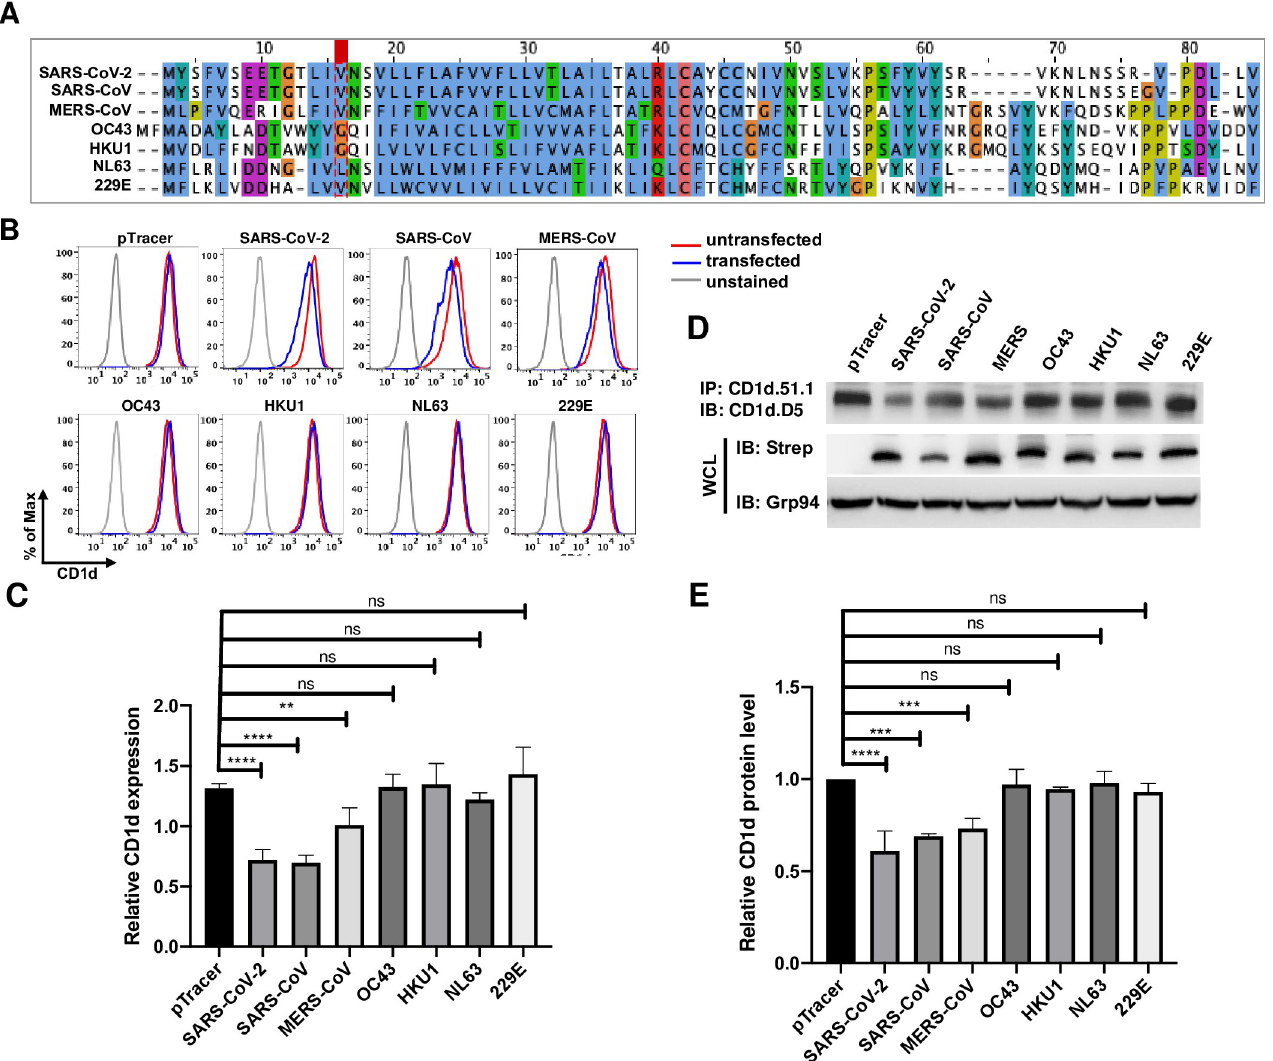
Fig 7. Only E proteins from highly pathogenic coronaviruses, but not common cold viruses downregulate CD1d expression. (A). Amino acid sequence alignment of E proteins from seven human coronaviruses. (B, C). 293T.CD1d cells were transfected to express individual E proteins and 48 hours later, subjected to flow cytometry to examine the CD1d surface expression level. (D, E). Lysates of transfected cells were subjected to immunoprecipitation by anti- CD1d antibody (CD1d.51.1) and levels of mature CD1d protein were compared by western blotting. Whole cell lysates were western blotted by anti-Strep antibodies to examine the expression of individual E proteins from human coronaviruses. The relative CD1d expression level and relative CD1d protein level were calculated as in Fig 6. Statistical analyses were performed by unpaired Student’s t test and one-way ANNOVA test (C-F). * , ** , *** , **** : p < 0.05, p < 0.01, p < 0.001, p < 0.0001. ns: not